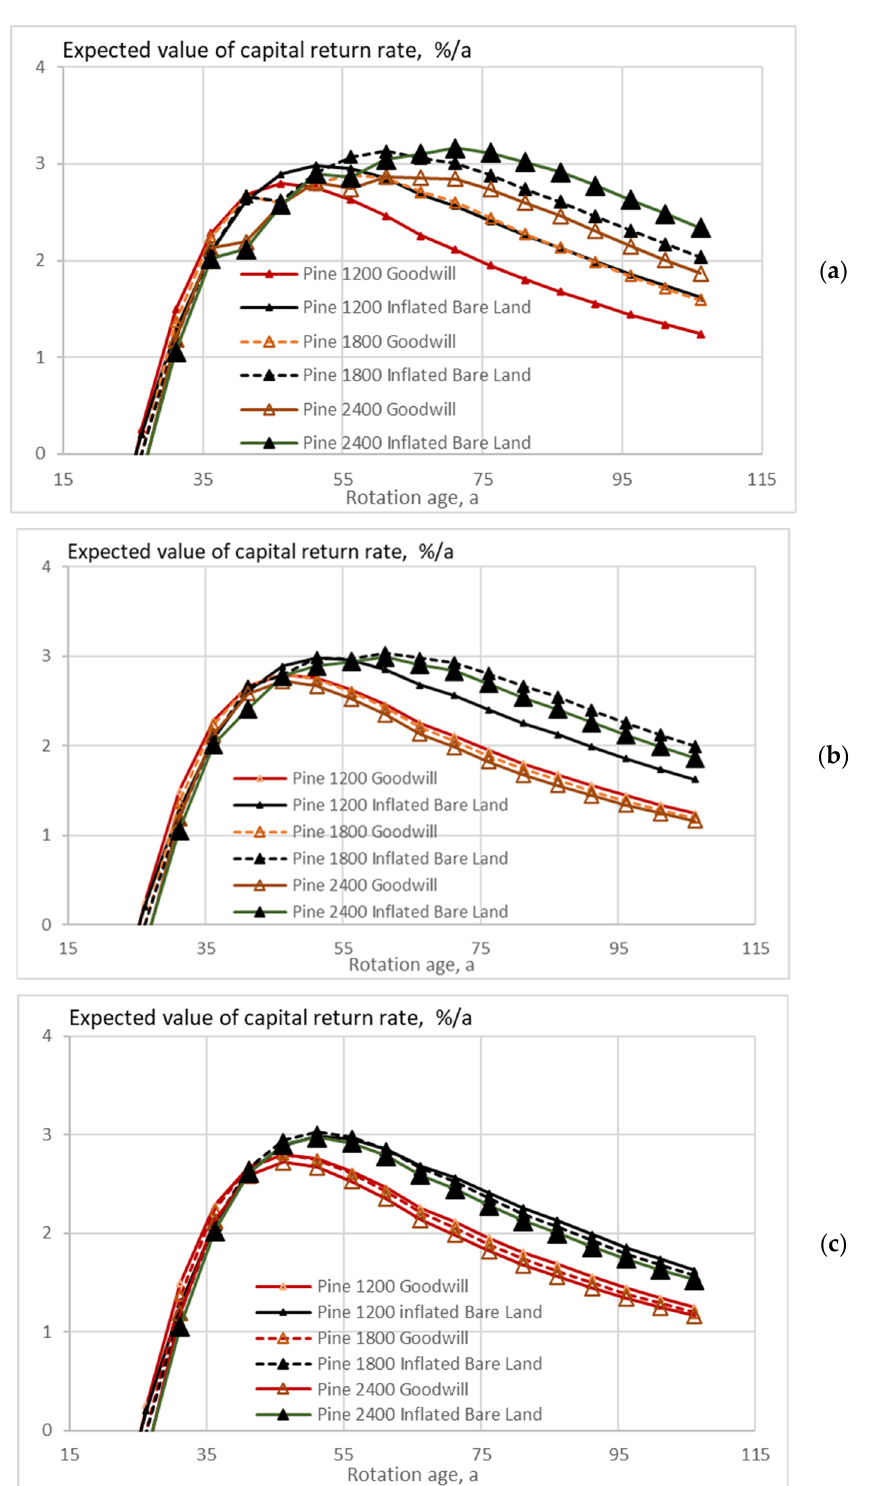
Figure 3. The expected value of capital return rate on pine ( Pinus sylvestris ) stands of different initial sapling densities, as a function of rotation age, when the growth model is applied as early as applicable, without any thinning restriction ( a ), in good-quality trees of at least 238 mm of diameter only removed in thinning ( b ), and without commercial thinning ( c ). Inflated capitalization is introduced either as proportional goodwill or as inflated bare land